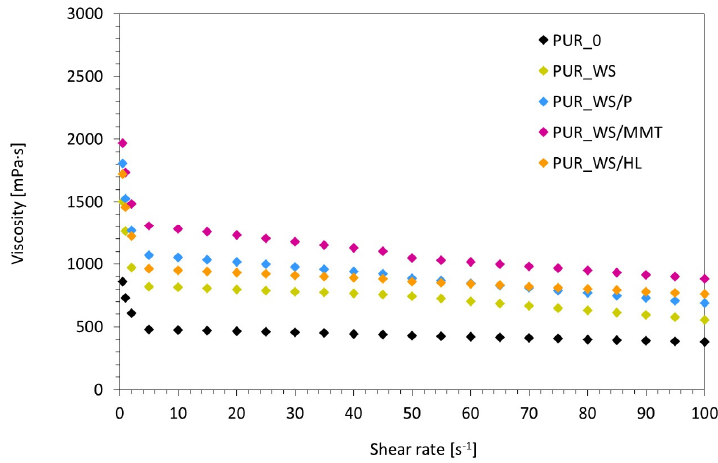
Figure 3. The results of dynamic viscosity of PUR systems containing WS fillers.